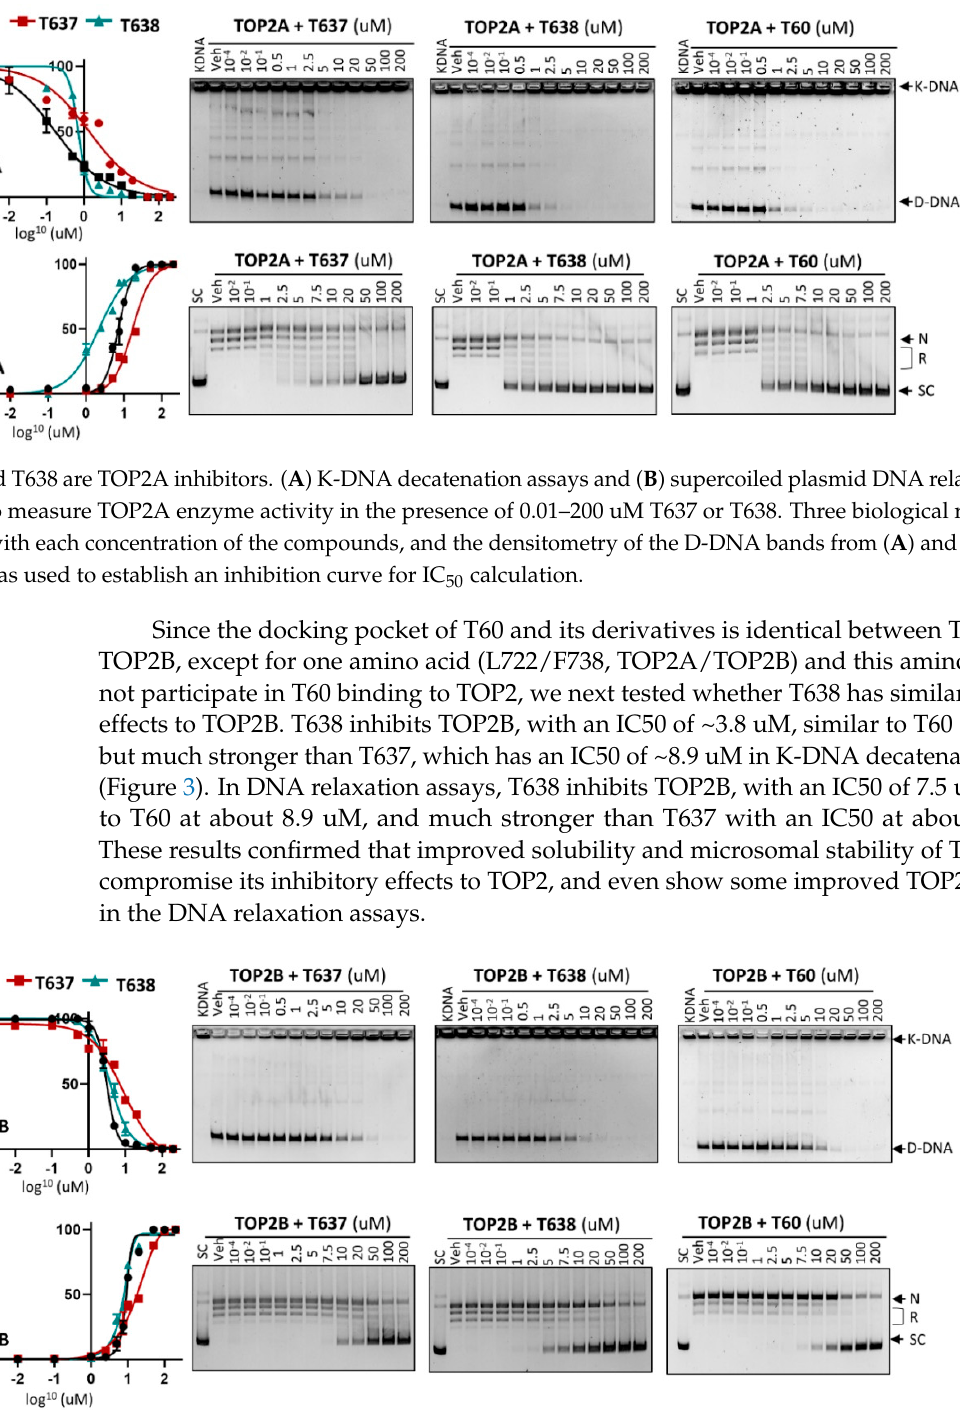
Figure 3. T637 and T638 are TOP2B inhibitors. ( A ) K-DNA decatenation assays and ( B ) supercoiled plasmid DNA relaxation assays are used to measure TOP2B activity in the presence of 0.01–200 uM T637 or T638. Three biological repeats were performed with each concentration of the compounds, and the densitometry of the D-DNA bands from ( A ) and the SC bands from ( B ) was used to establish an inhibition curve for IC 50